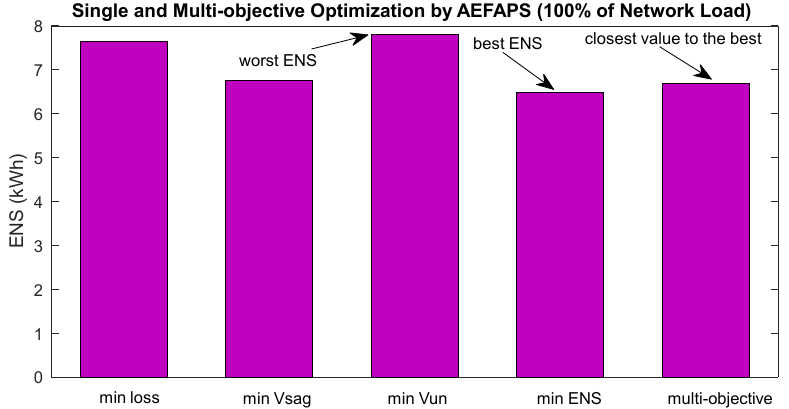
Figure 9. The ENS in single-criterion and many-criteria optimizations using AEFAPS.